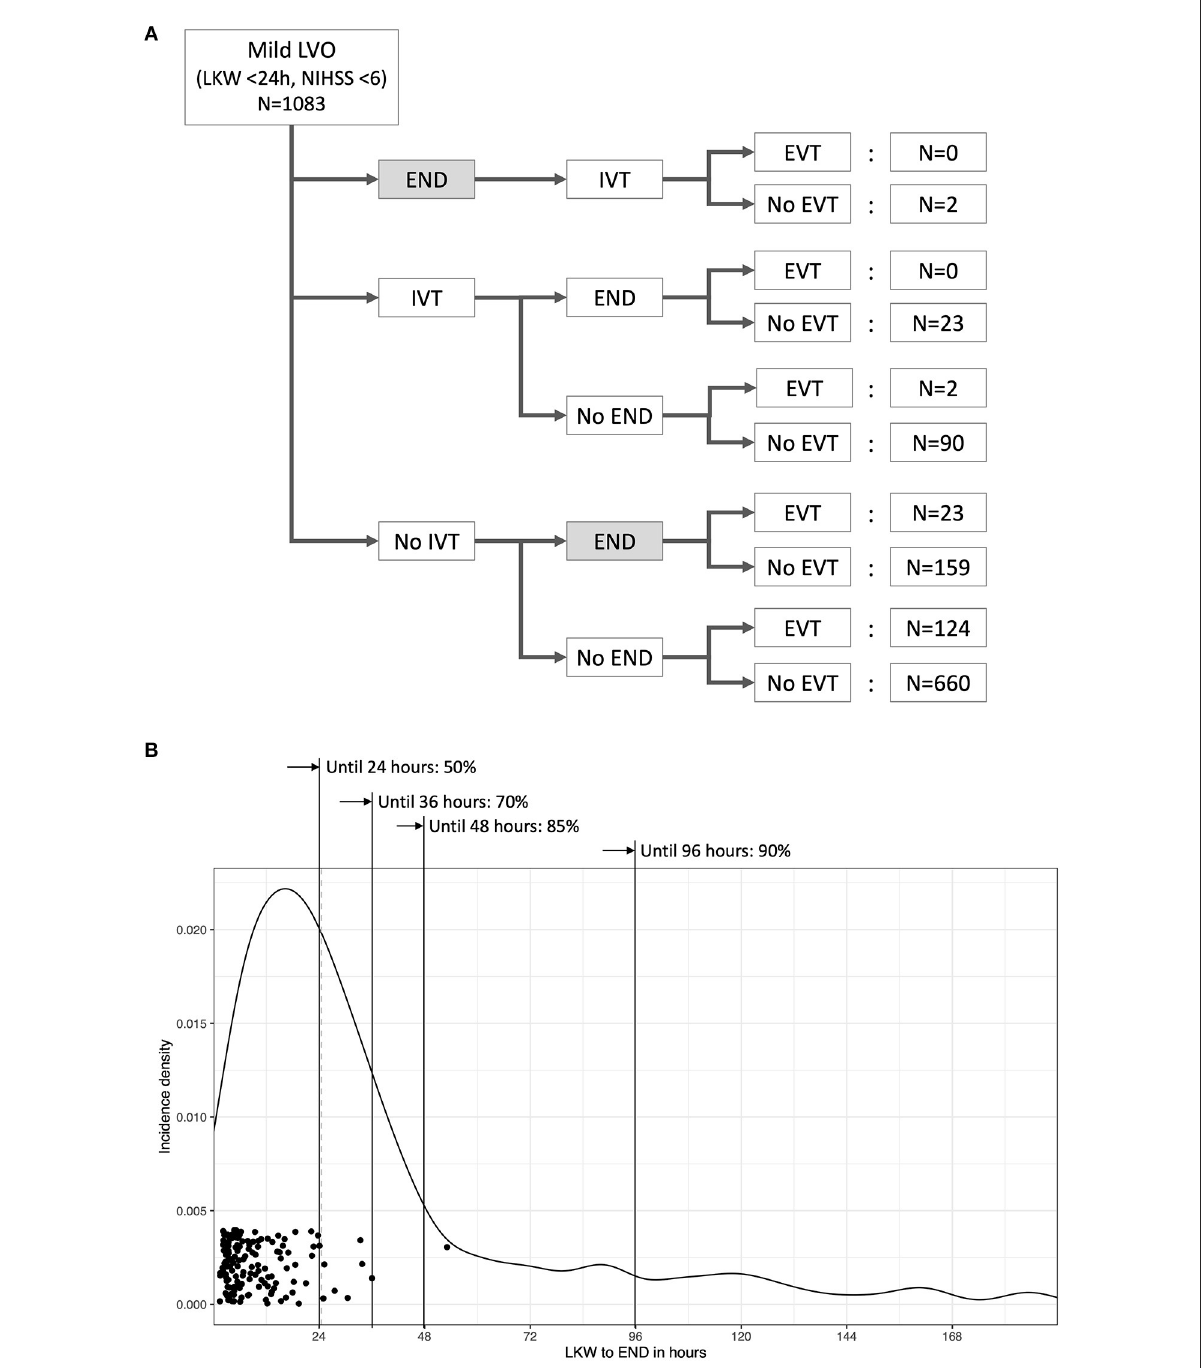
FIGURE2 Temporal profile of early neurological deterioration (END) related to recanalization treatments for acute LVO patients with mild neurological deficits. Only ENDs captured before the initiation of EVT were counted for the present study. Of 207 ENDs (19% of all patients) that occurred before the initiation of EVT, 23 developed after intravenous thrombolysis. Five ENDs were symptomatic hemorrhages, one END occurred after intravenous thrombolysis and four ENDs occurred without recanalization treatment (A) . The median time from the last known well (LKW) to END was 24.5h, and 85% of ENDs developed within 48h from the time LKW. Dots represent the time of arterial puncture for EVT (B)